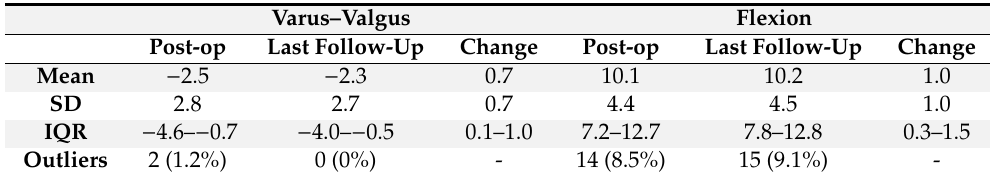
Table 3. Femoral implant position angles (values in ◦ ). Positive values indicate varus and flexion. Negative values indicate valgus and extension. n = 164.